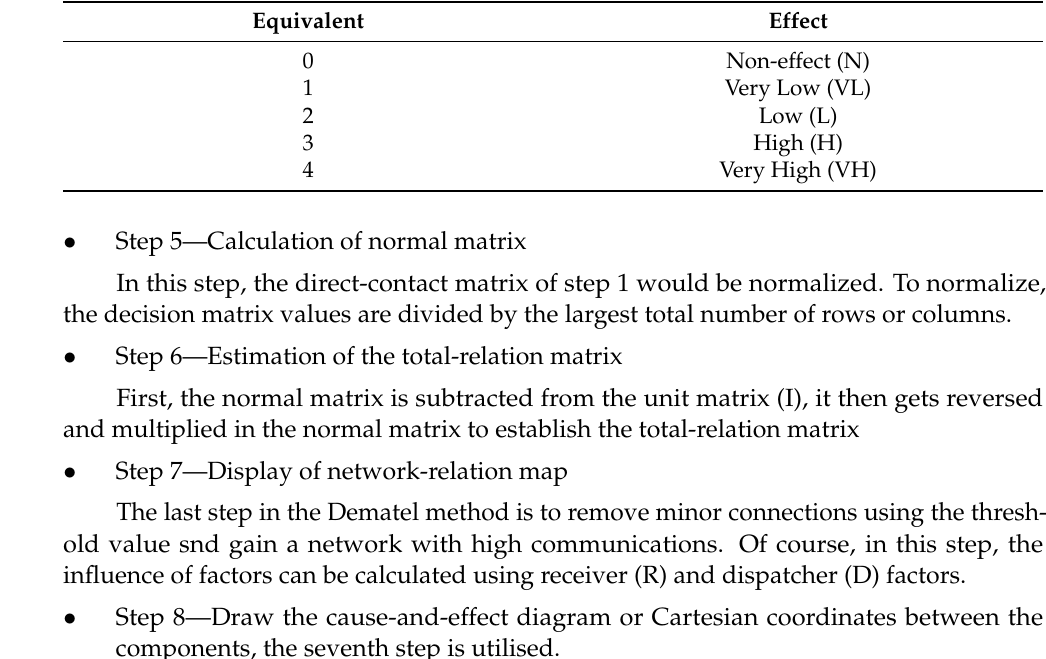
Table 1. The spectrum used for the